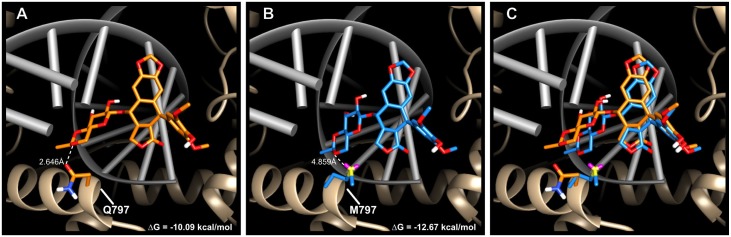
Etoposide docked into the C. elegans TOP-2 homology model.Etoposide docked into the (A) glutamine-containing Bristol TOP-2 enzyme (ΔG = -10.09 kcal/mol), (B) methionine-containing Hawaii TOP-2 enzyme (ΔG = -12.67 kcal/mol), and (C) the overlay of both structures. Glutamine is colored in orange, and methionine is colored in blue. Etoposide docked into the glutamine-containing TOP-2 enzyme is orange, and etoposide docked into the methionine-containing TOP-2 enzyme is blue. DNA is colored in gray, and the ribbon representation of the TOP-2 protein is shown in tan.